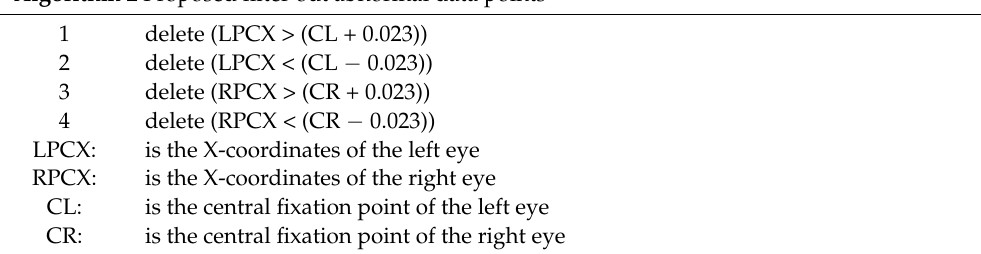
Algorithm 2 Proposed filter out abnormal data points